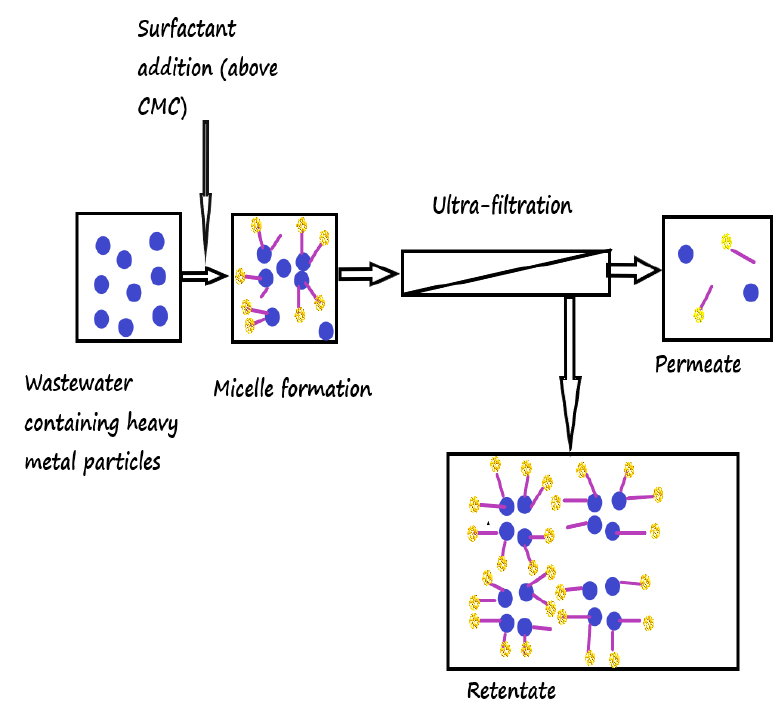
Figure 2. Process of Micellar Enhanced Filtration.